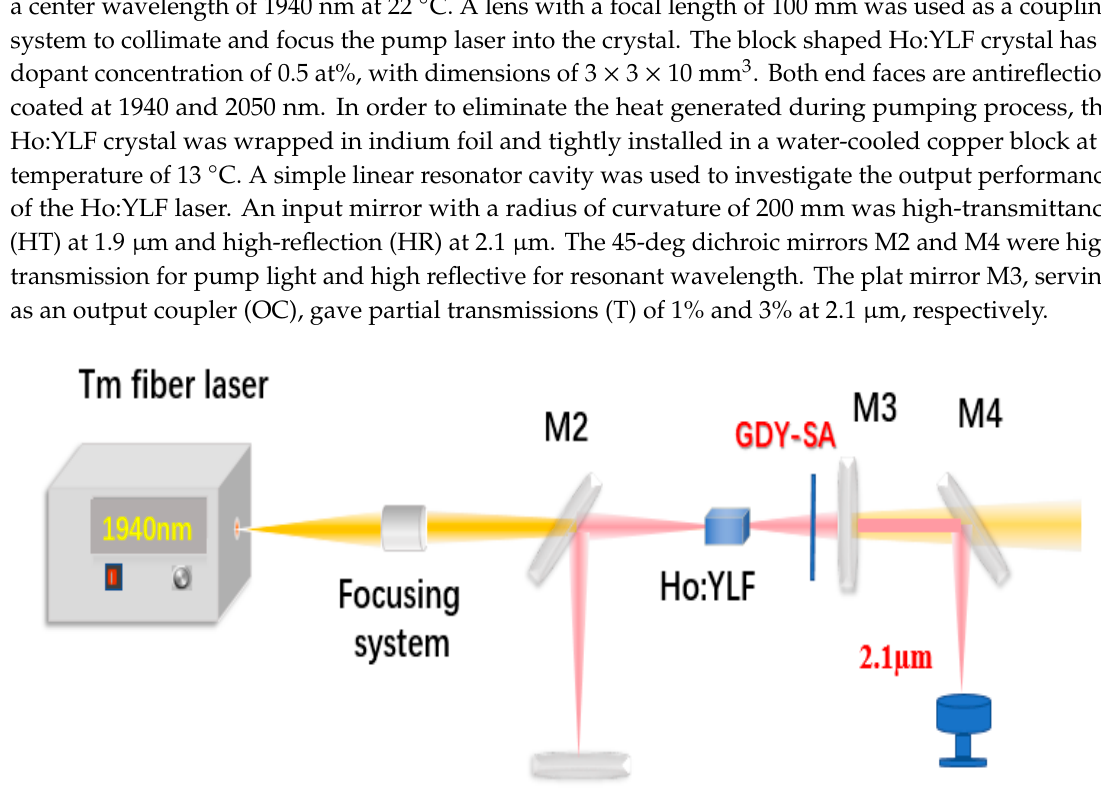
Figure 3. The schematic of the experimental setup for the passively Q-switched (PQS) operation.